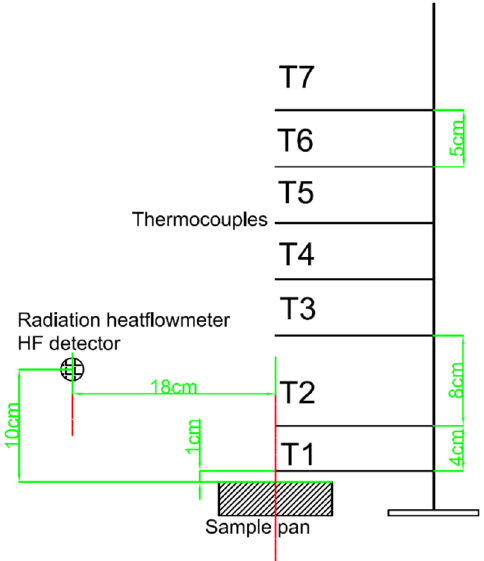
Figure 2. Positions of thermocouples and radiation heatflowmeter in Lhasa and Lijiang. Only No. T1 and T2 thermocouples were applied in Hefei.